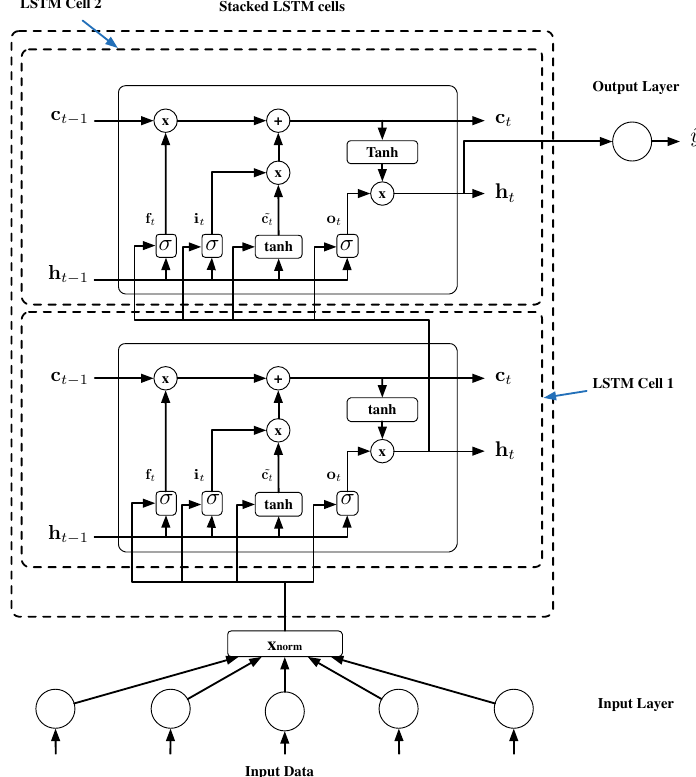
Figure 6. Two stacked Long-Short Term Memory (LSTM) cells. can be either S NH , e or S Ntot , e